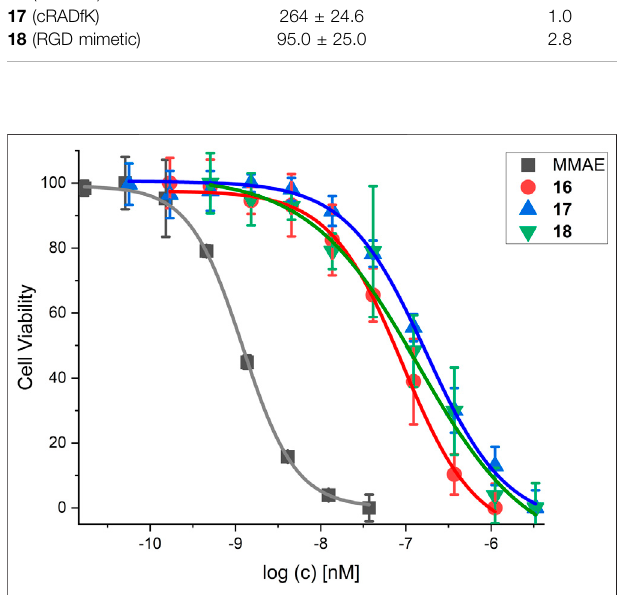
FIGURE 12 | Cell viability assay for SMDC 18 in comparison to control compounds and the free drug MMAE. For IC 50 values, see Table 7